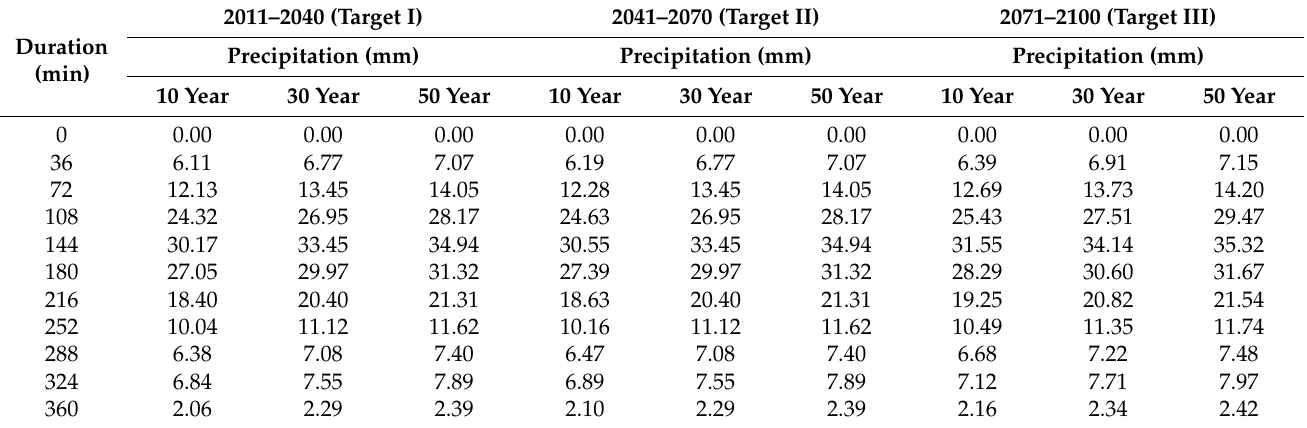
Table 5. Predicted probable precipitation for three target periods for the duration of 6 h in Changwon City [47].